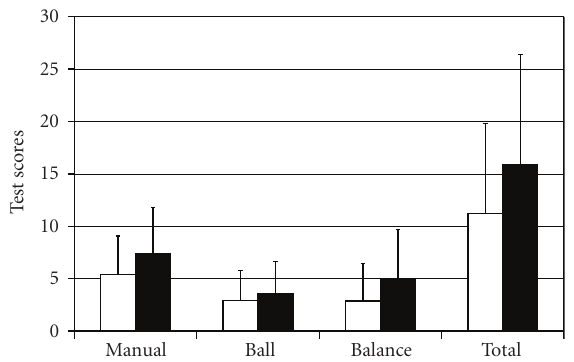
Figure 3: Plot of Movement ABC scores by test subset in HI children. White columns = HI children with a VEMP response on one or both sides ( N = 7); Dark columns = HI children with no VEMP ( N = 11).